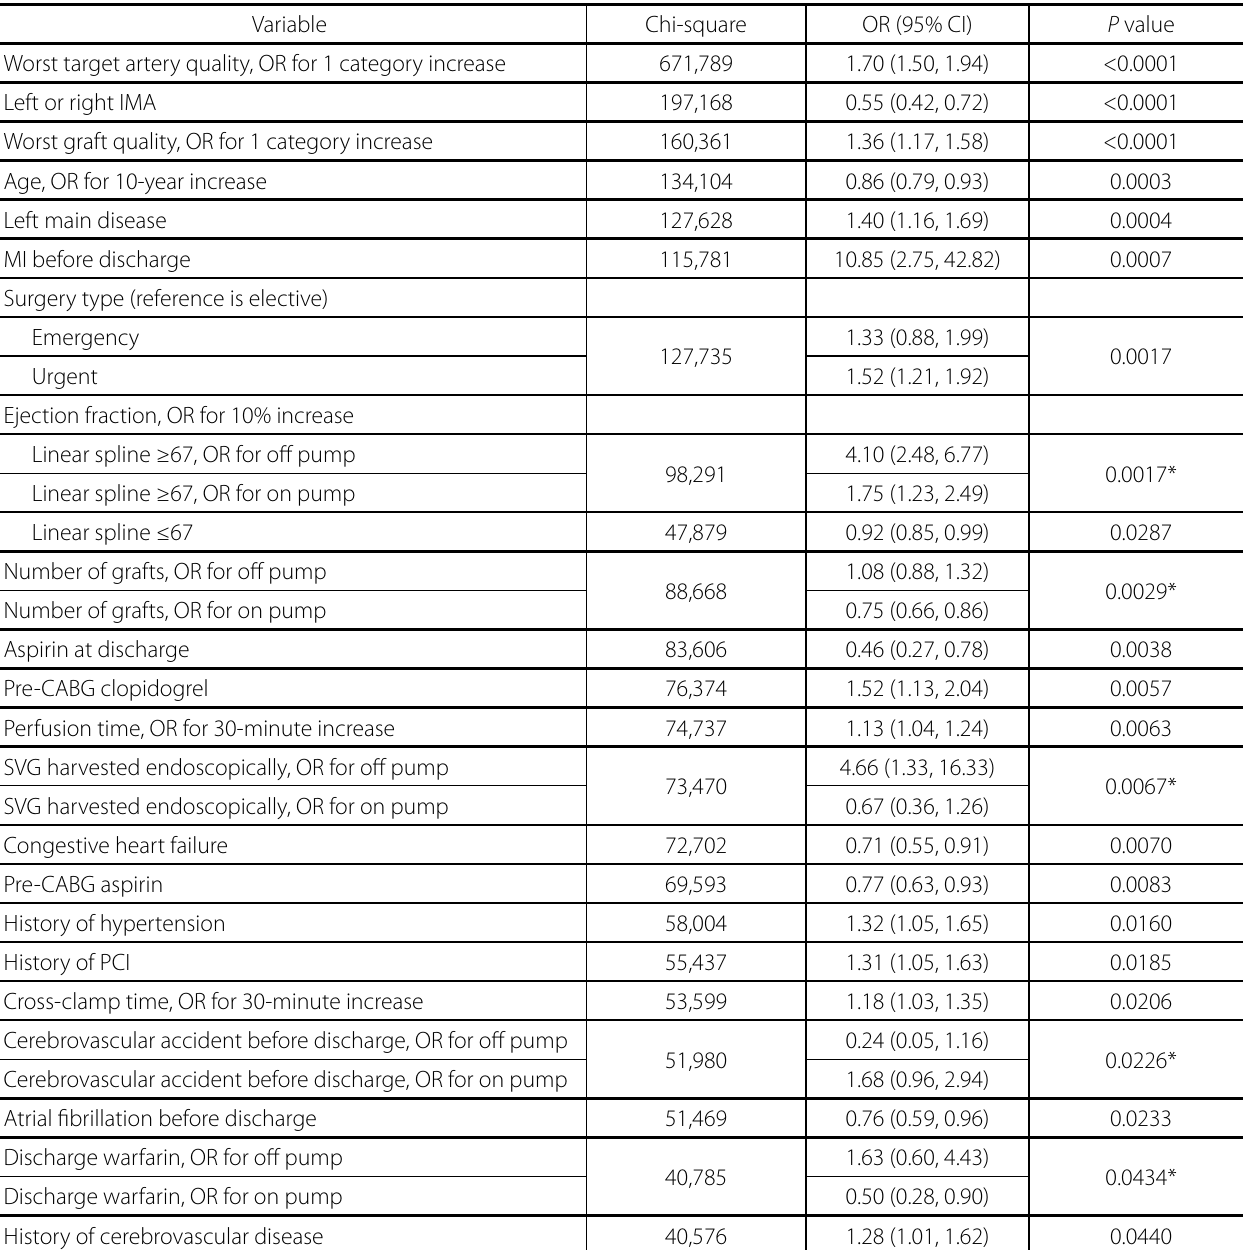
Table 3. Multivariable associations with clopidogrel use after CABG (N=4887). Variable